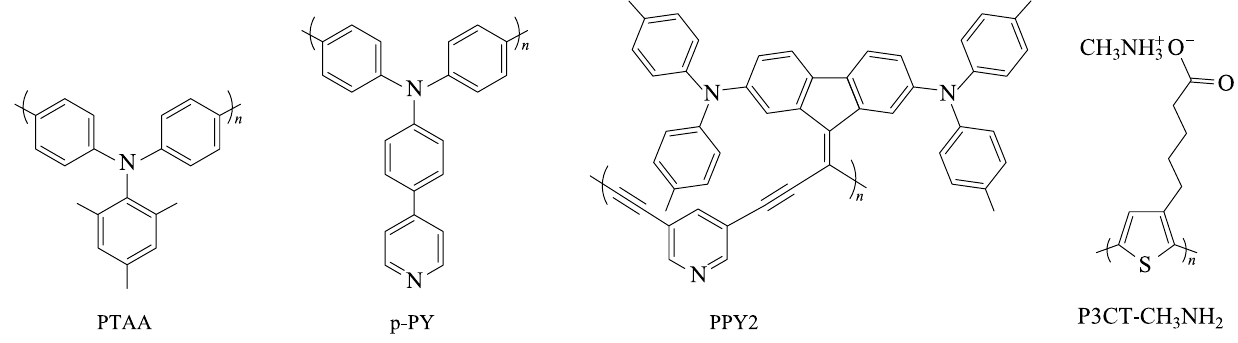
Fig. 2 Chemical structure of representative polymer HTMs for efficient inverted PVSCs